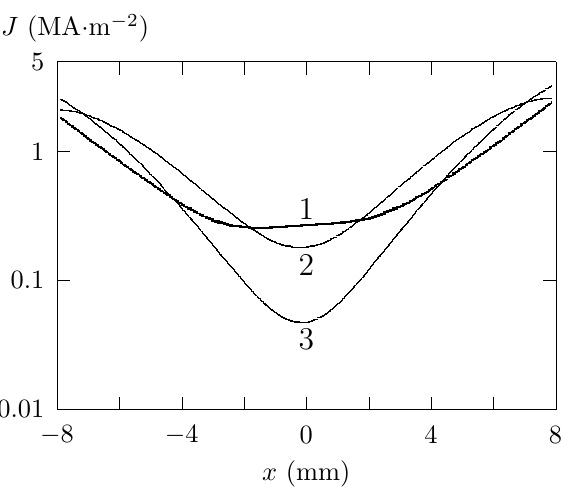
Figure 6. Example 3, d = 100 mm, f = 1 kHz, α = 0: The dependence of current density on x for y = 0 in the conductor A 1 . (1) The amplitude of current density in steady state; (2) t = 0.49 ms, the value of the current I is maximum; (3) t = 0.37 ms, maximum current density. Table 1 gives the values J max / ˆ J max and I max / ˆ I in dependences on f , d and (cid:36) . The